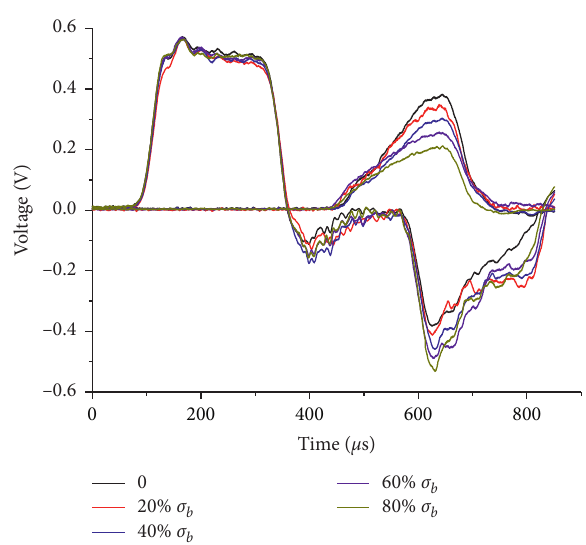
Figure 4: Schematic diagram of stress wave propagation in sandstone with damage degree under impact